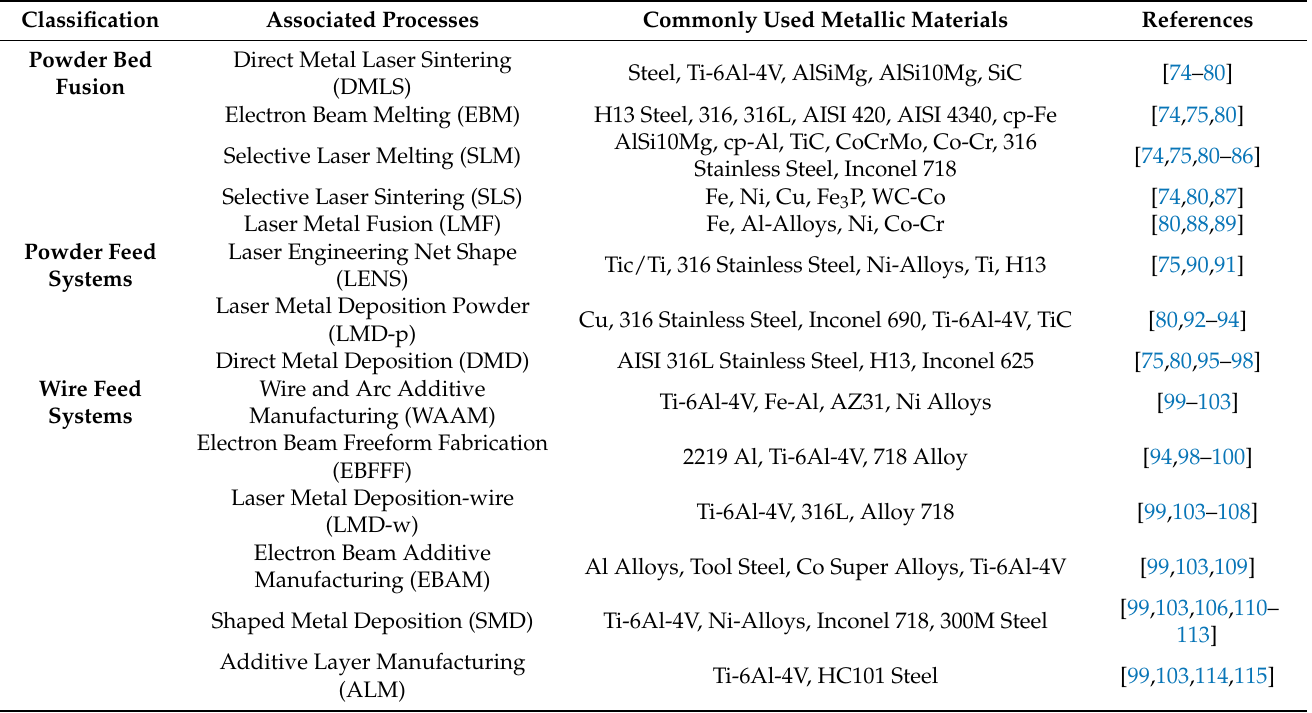
Table 3. A summation of the common processes and materials associated with PBF, PFS and WFS.